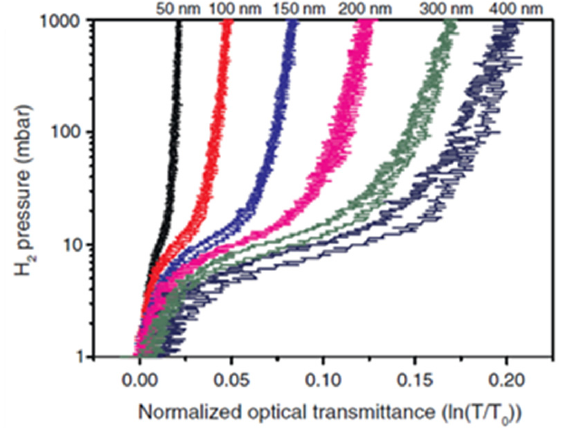
Figure 5. Pressure transmission isotherms for nanoparticulate Pd 88 Au 12 thin films with thicknesses ranging from 50 to 400 nm. Adapted from [41], with permission from Elsevier, 2015.